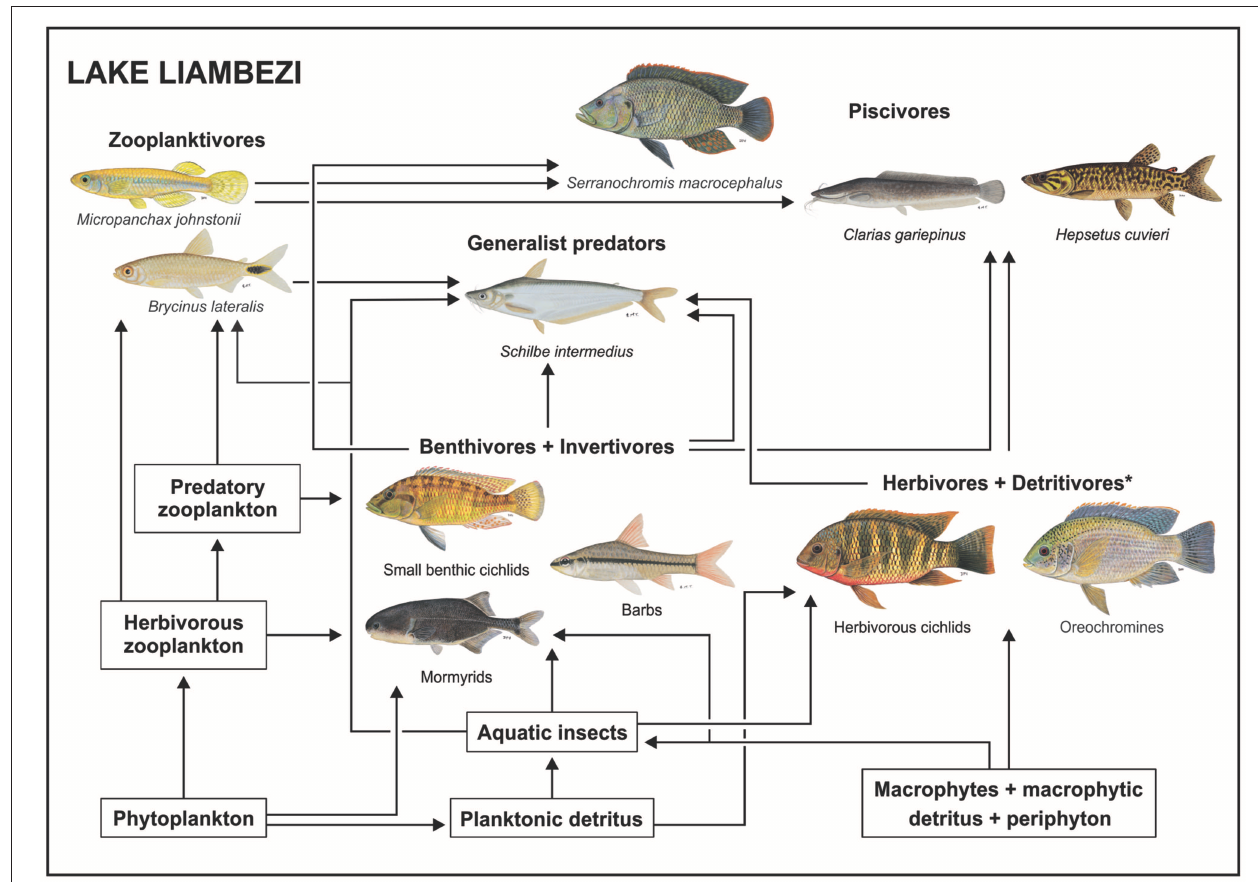
FIGURE 6 | Conceptual diagram of the food web in Lake Liambezi, illustrating the flow of energy through three major food chains, and their integration by generalist predators and piscivores in the mature lacustrine fish community. *Herbivores and detritivores incorporate all the tilapiine cichlids. All fish images are ©